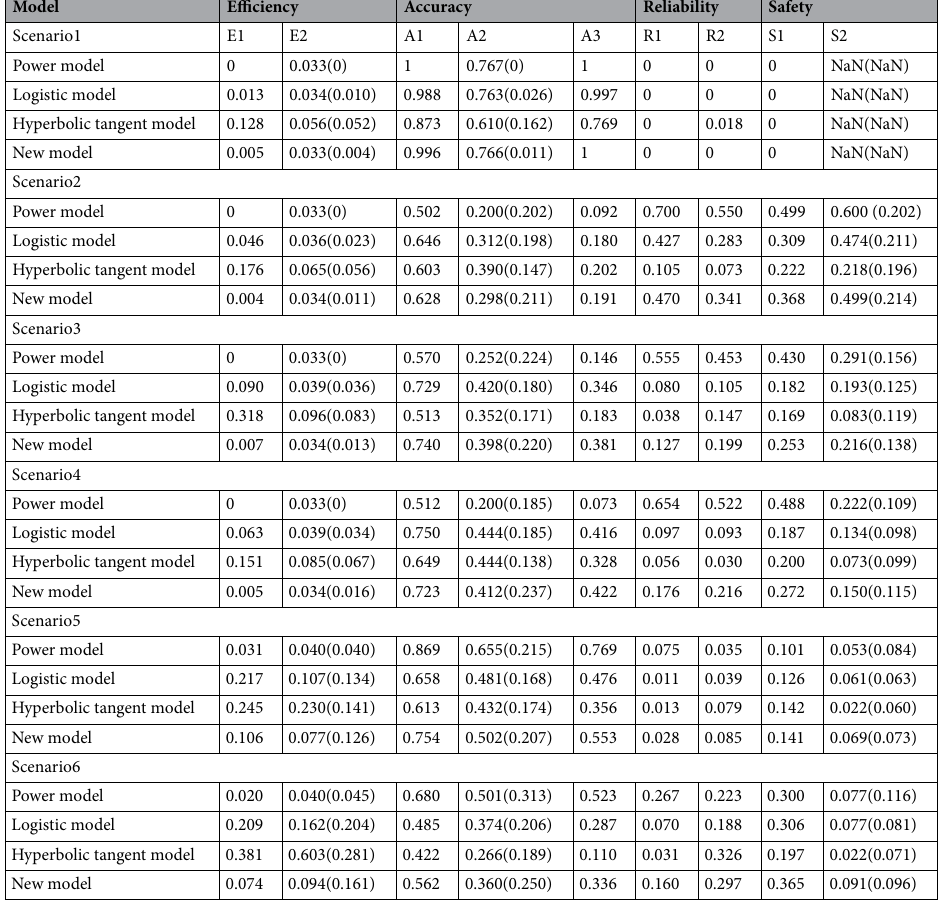
Table 3. EARS for the power, logistic, hyperbolic tangent model and the new